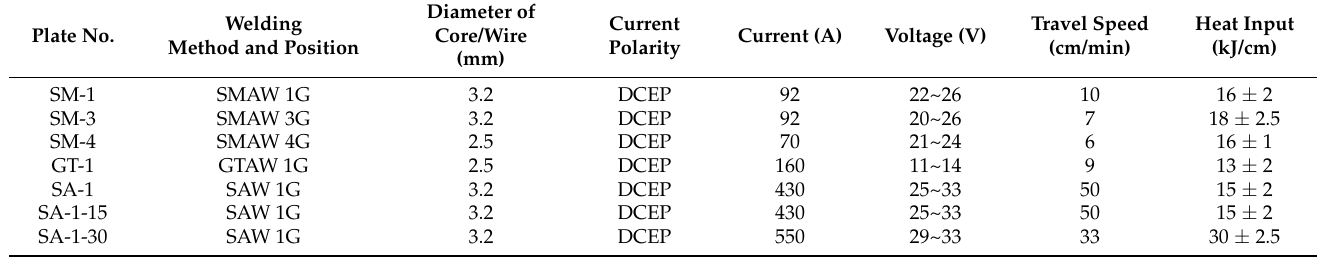
Figure 2. Appearance of the SM ‐ 1 test plate. Table 4. Welding parameters.